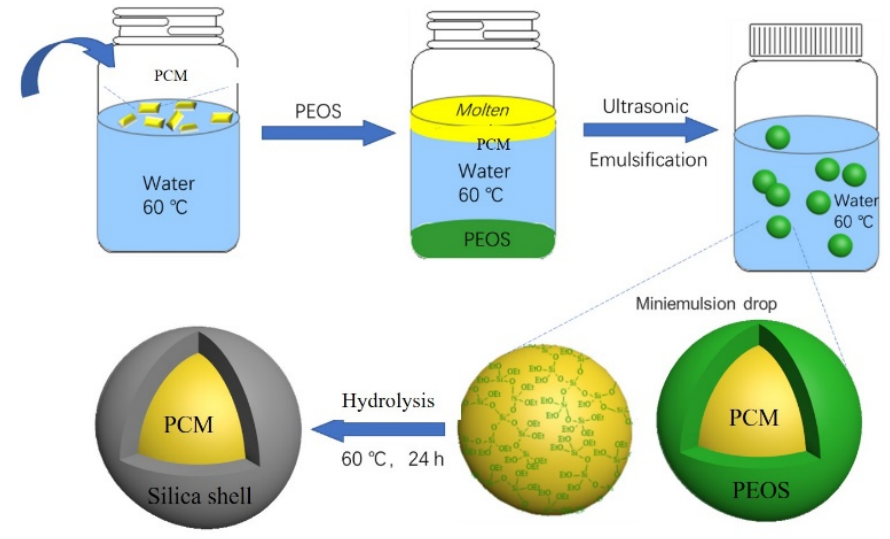
Figure 2. Illustration of formation mechanism of silica-based core-shell nanocapsules.